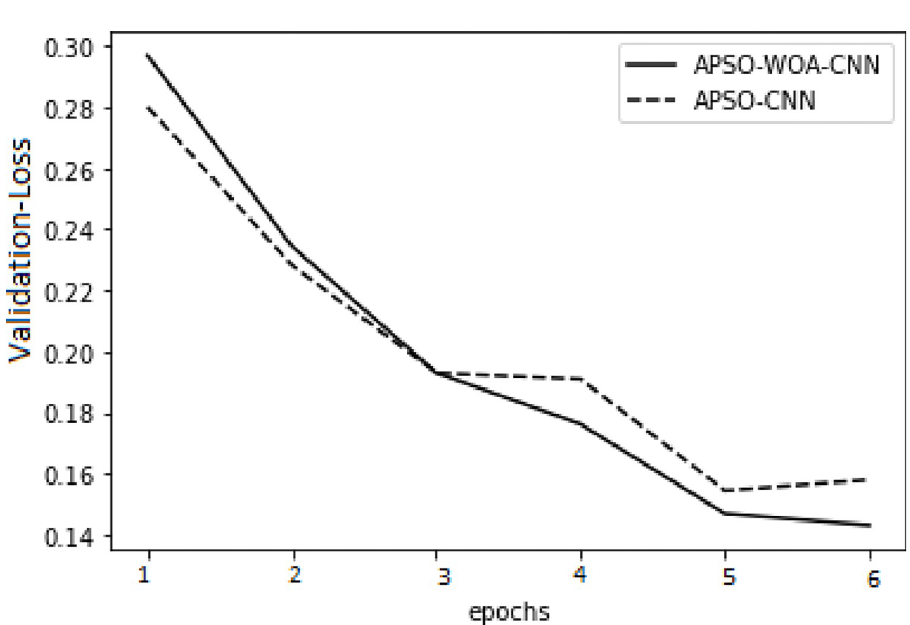
Fig 15. APSO–WOA–CNN and APSO–CNN algorithms’ loss function validation